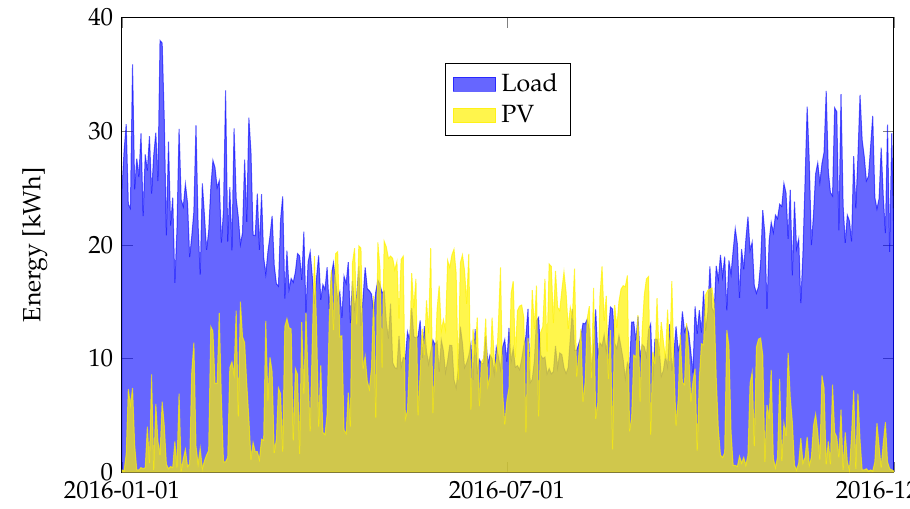
Figure 2. Daily load demand and PV generation of the residential building.